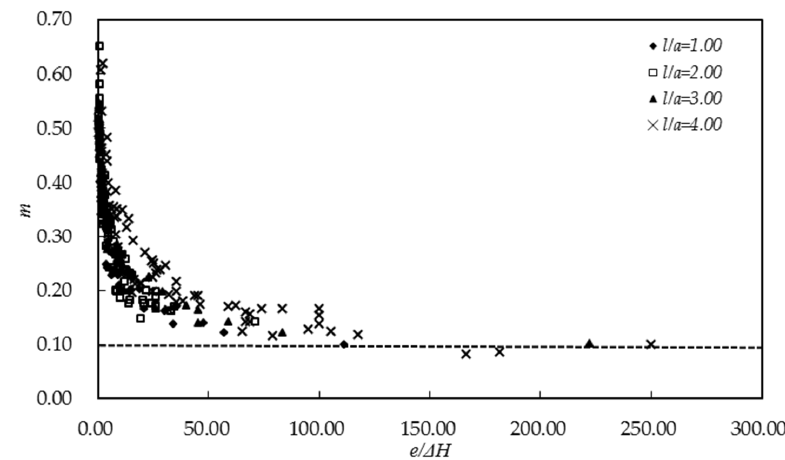
Figure 5. The plot of m versus e / ∆ H for l / a values.